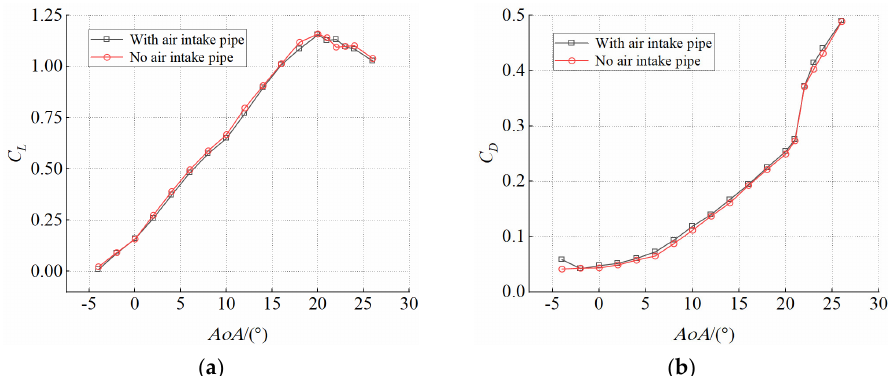
Figure 3. Influence of air pipe on aerodynamic force. ( a ) Lift coefficient. ( b ) Drag coefficient.